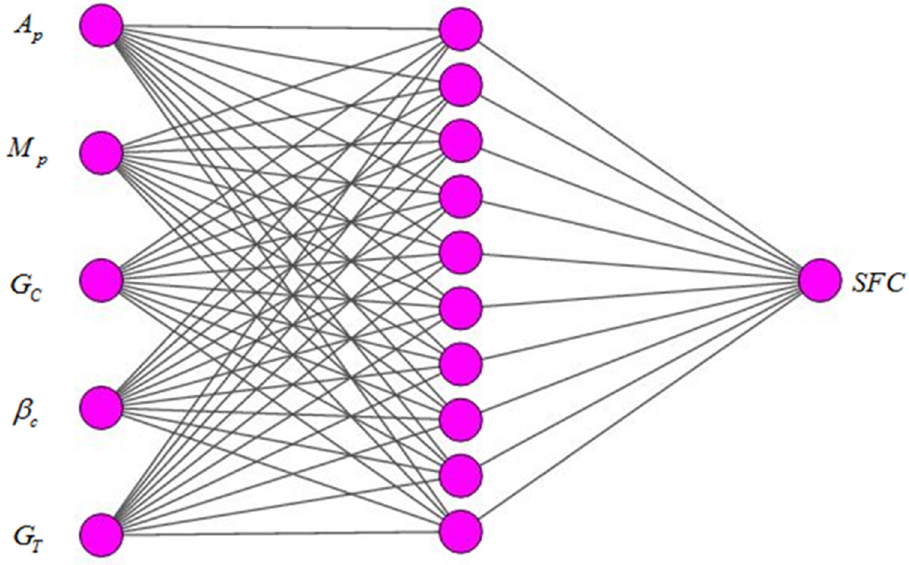
Figure 2. Architecture of network model.